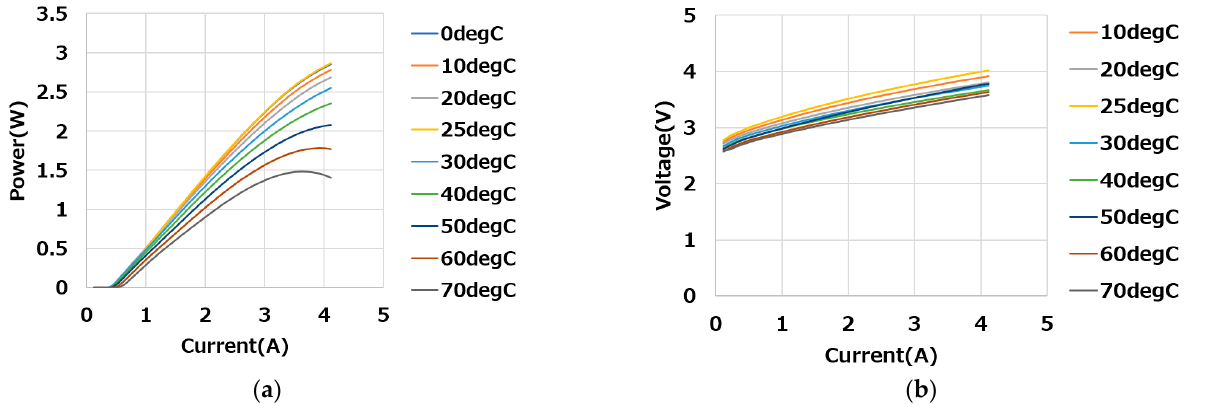
Figure 8. ( a ) I – L and ( b ) I – V characteristics of the SS-VCSEL during all-blocks emission at different temperatures.